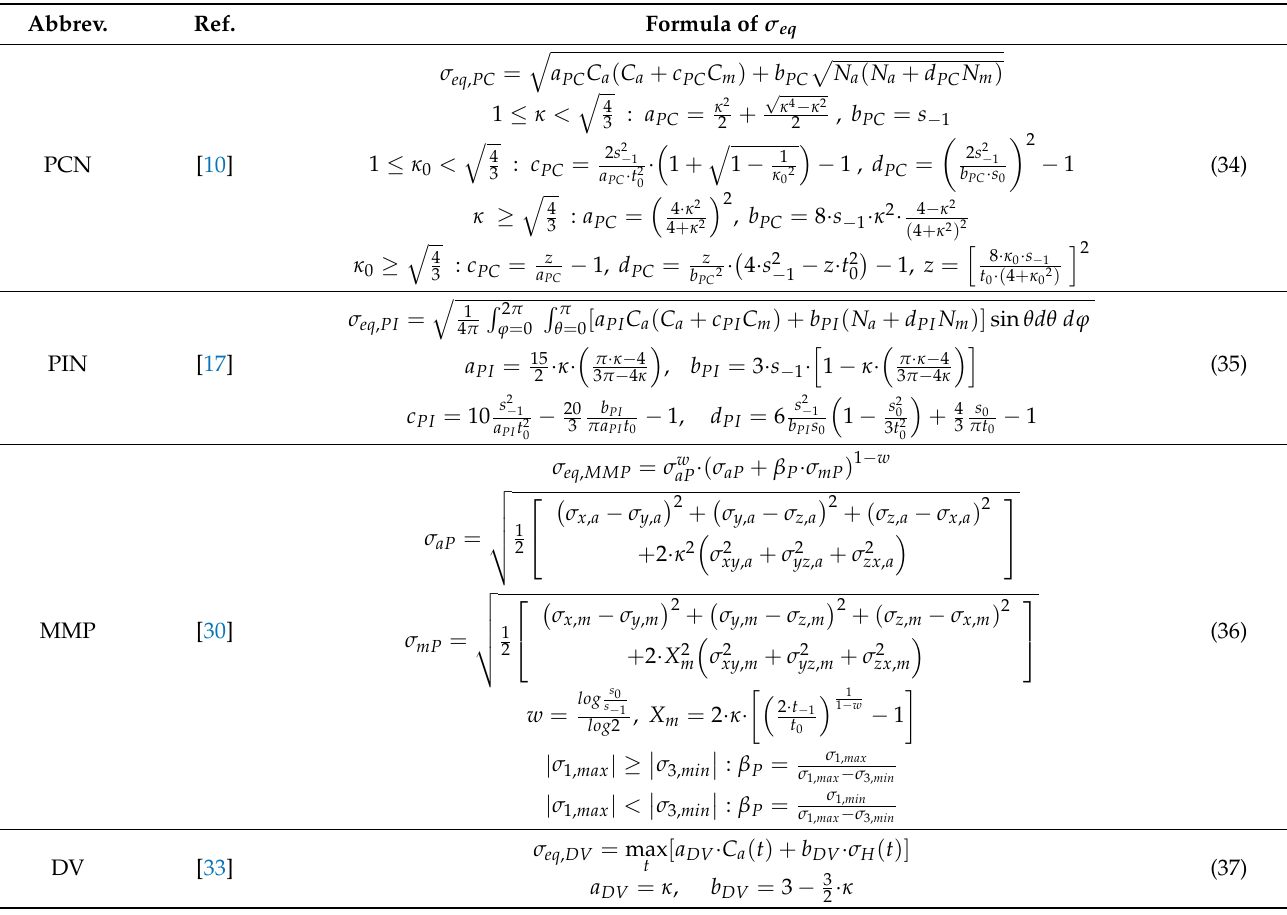
Table 3. Formulations of individual reference multiaxial fatigue strength criteria. Abbrev.